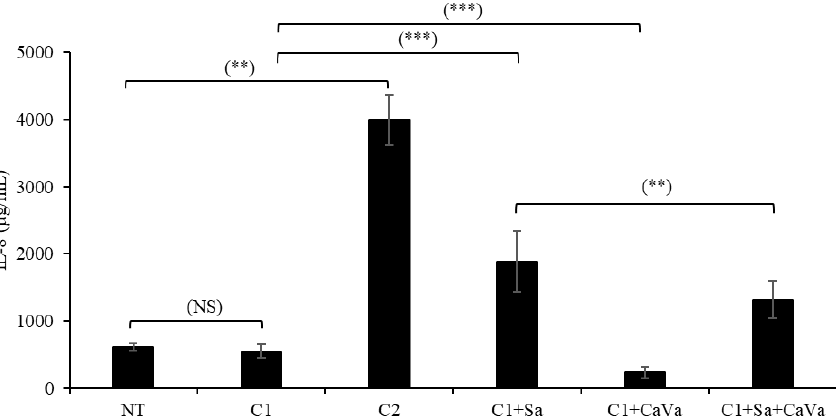
Figure 5. Induction of IL-8 release in RHEs treated with cytokines alone or with either S. aureus (Sa), Castanea sativa (CaVa) or both, as indicated (C1, 5 ng/mL; C2, 20 ng/mL). IL-8 secretion by keratino- cytes was measured in RHE culture media by ELISA. n = 7 – 12, mean ± SD, Mann – Whitney. NS: not significant; **, p < 0.01; ***, p < 0.001.